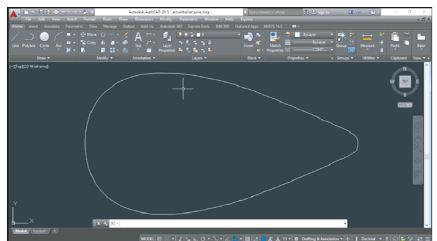
Figure 2: 2D design of NACA 0024 using Bezier curve.